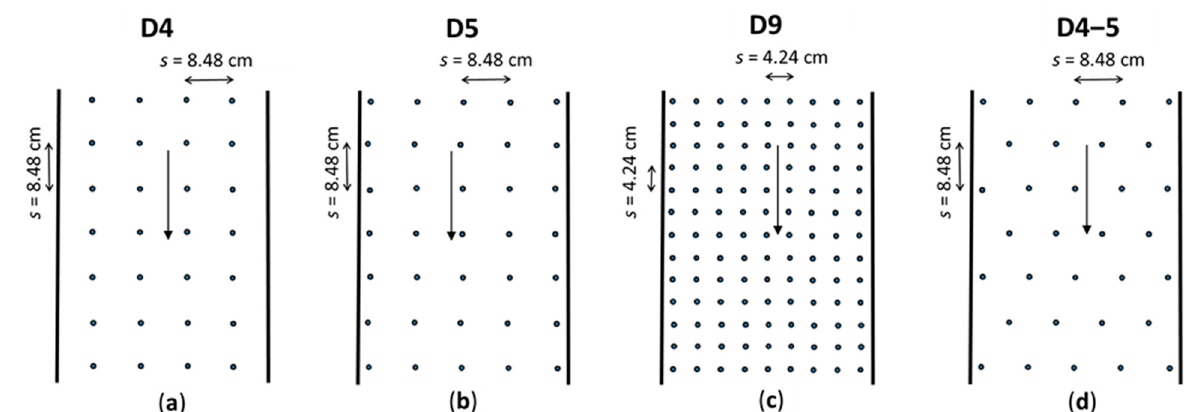
Figure 2. Stem arrangements: ( a ) D4; ( b ) D5; ( c ) D9; ( d ) D4-5.